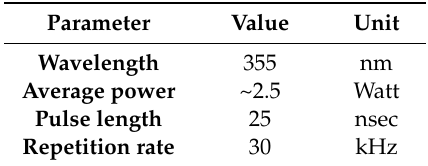
Table 1. UV pulsed 355 nm laser